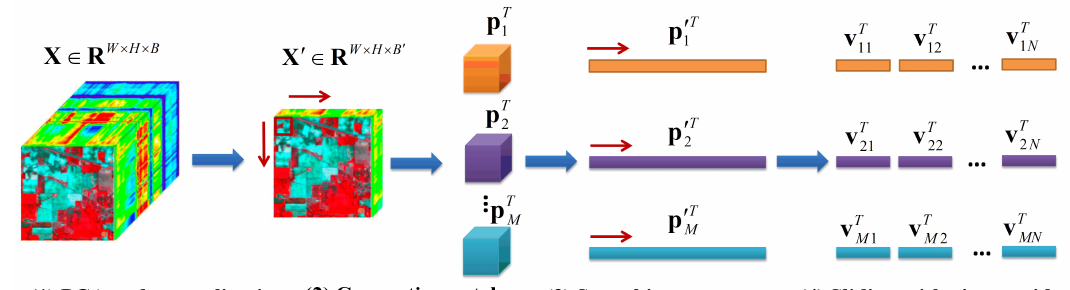
Figure 2. Hyperspectral image preprocessing and instances’